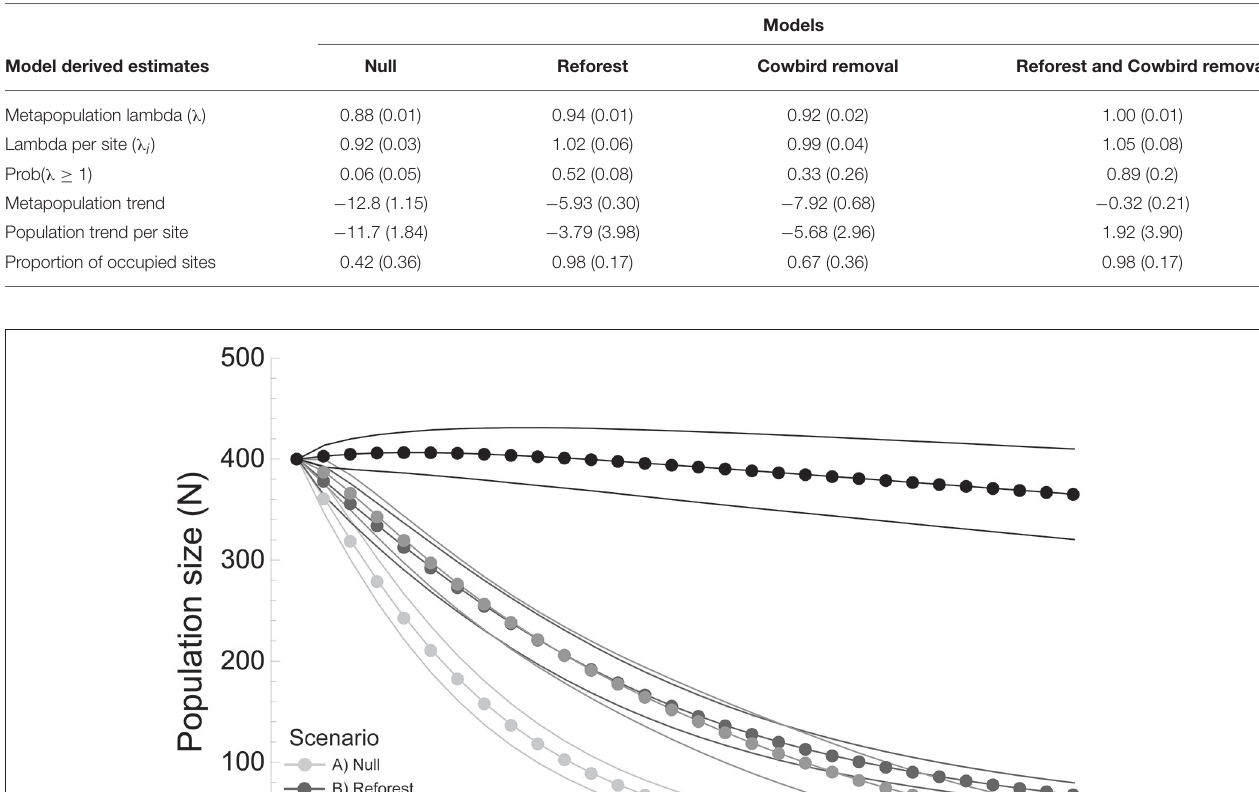
TABLE 4 | Model-estimated means (SD) for metapopulation lambda ( λ ), lambda per site ( λ i ), probability λ ≥ 1, annual population trend (%), and the proportion of occupied sites for four model